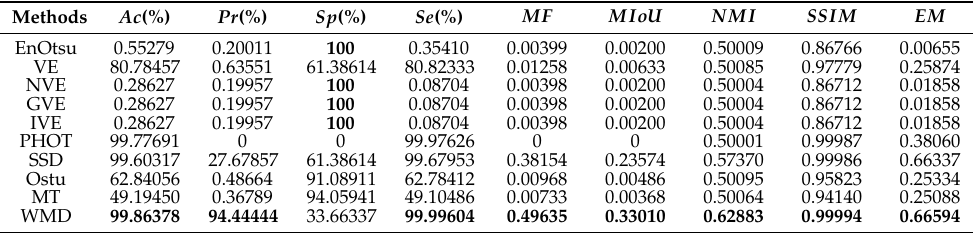
Table 2. Results on weight matrix of magnetic tile image in terms of Ac (%), Pr (%), Sp (%), Se (%), MF , MIoU , MI , NMI , SSIM , and EM